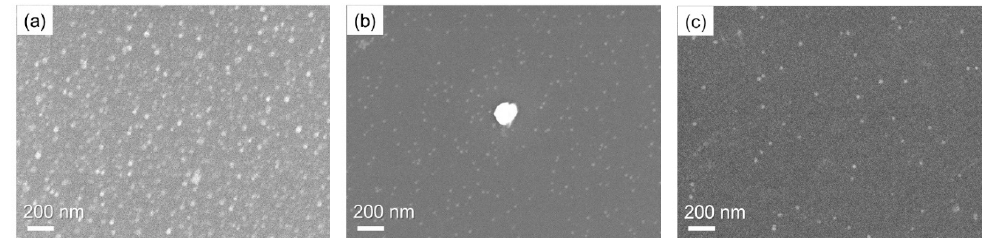
Figure 5. Scanning electron microscopy (SEM) photographs of GNPs after aggregation. ( a ) GNPs after addition of 2 mM L-cysteine into the dispersion solution of 2 wt% gold mass concentration. ( b ) GNPs after addition of 5 mM L-cysteine into the dispersion solution of 4 wt% gold mass concentration. ( c ) GNPs without L-cysteine into the dispersion solution of 4 wt% gold mass concentration.